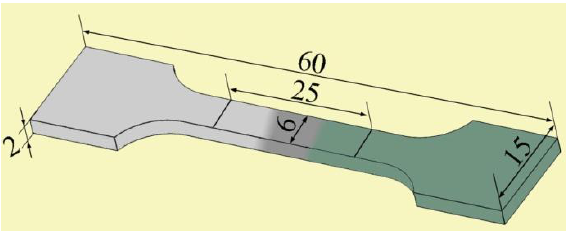
Figure 2. Sketch of butt welding tensile test specimens